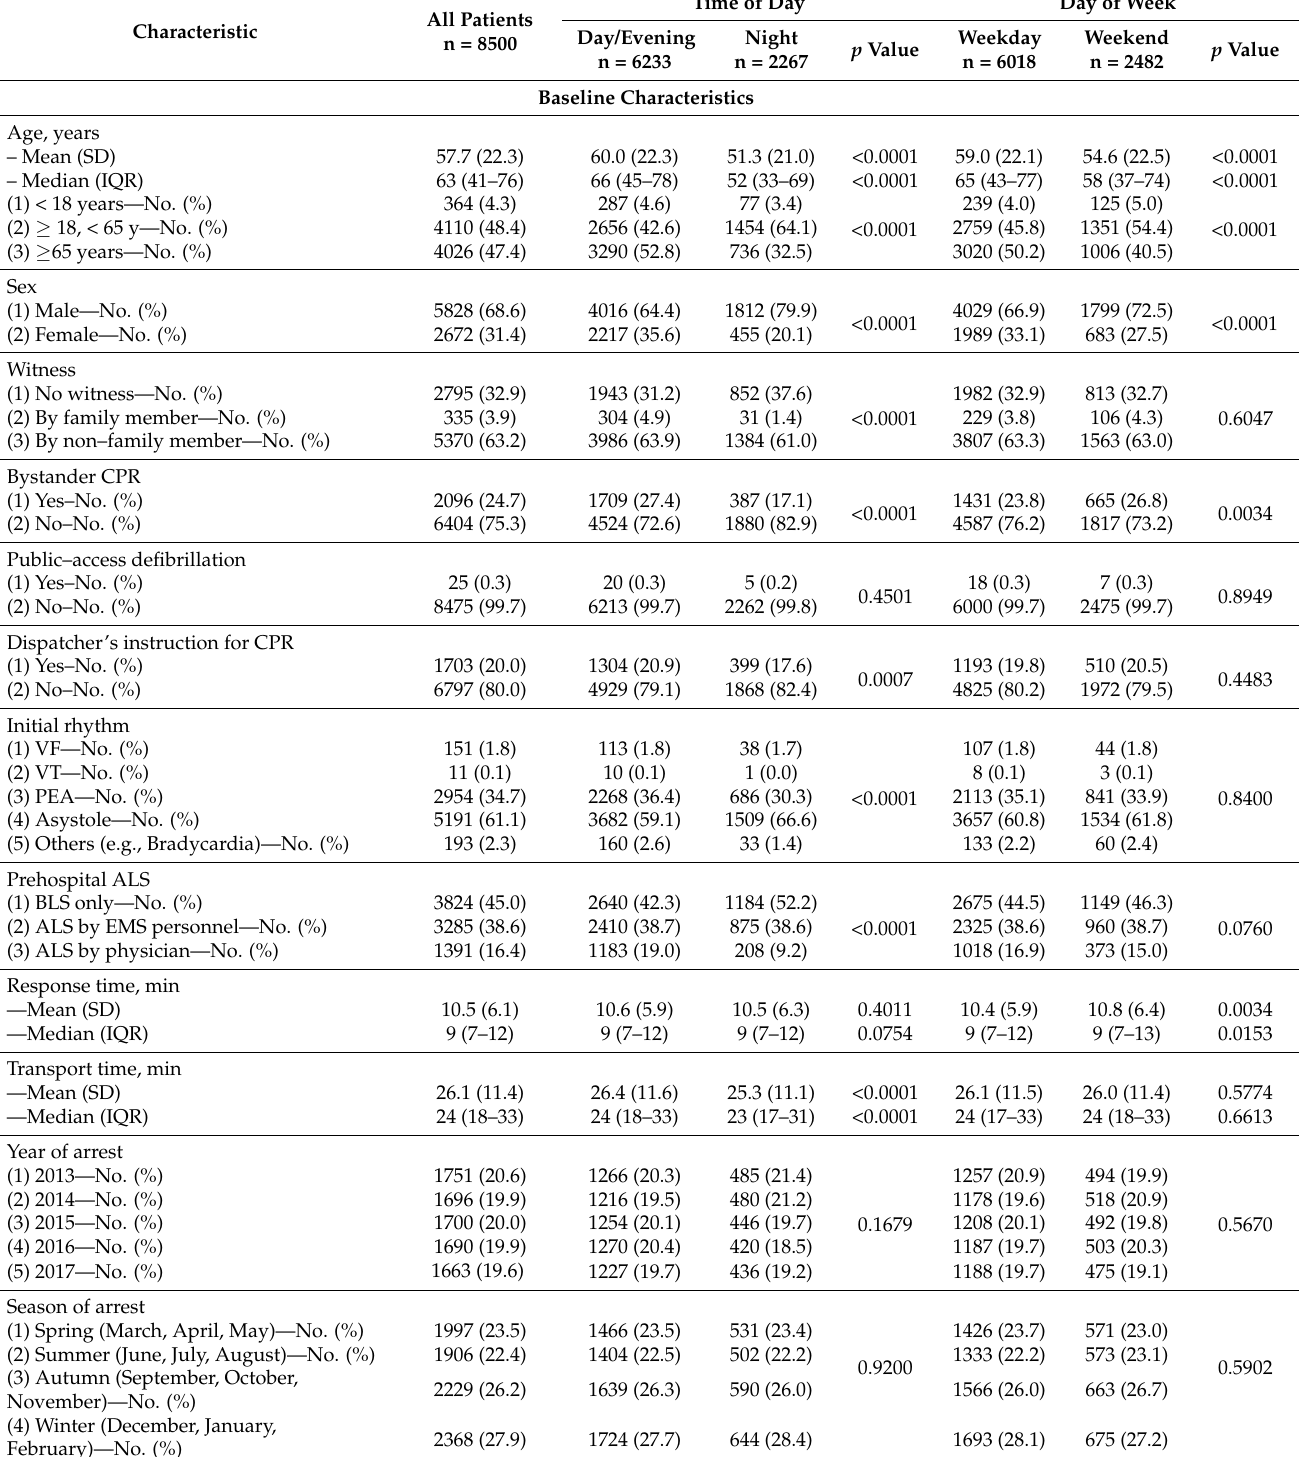
Table 1. Baseline characteristics according to time of day and day of week in the full